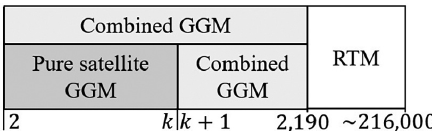
Figure 1. Simplified principle of Spectral Enhancement Method (SEM) (Hirt et al., 2011)